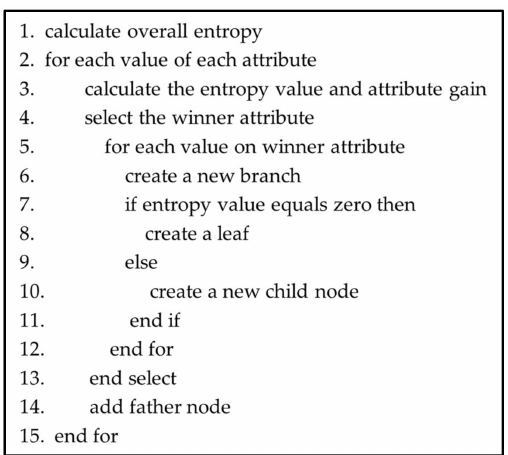
Figure 4. Pseudo-code example (Decision Tree—ID3), adapted from Ferreira et al. [70].